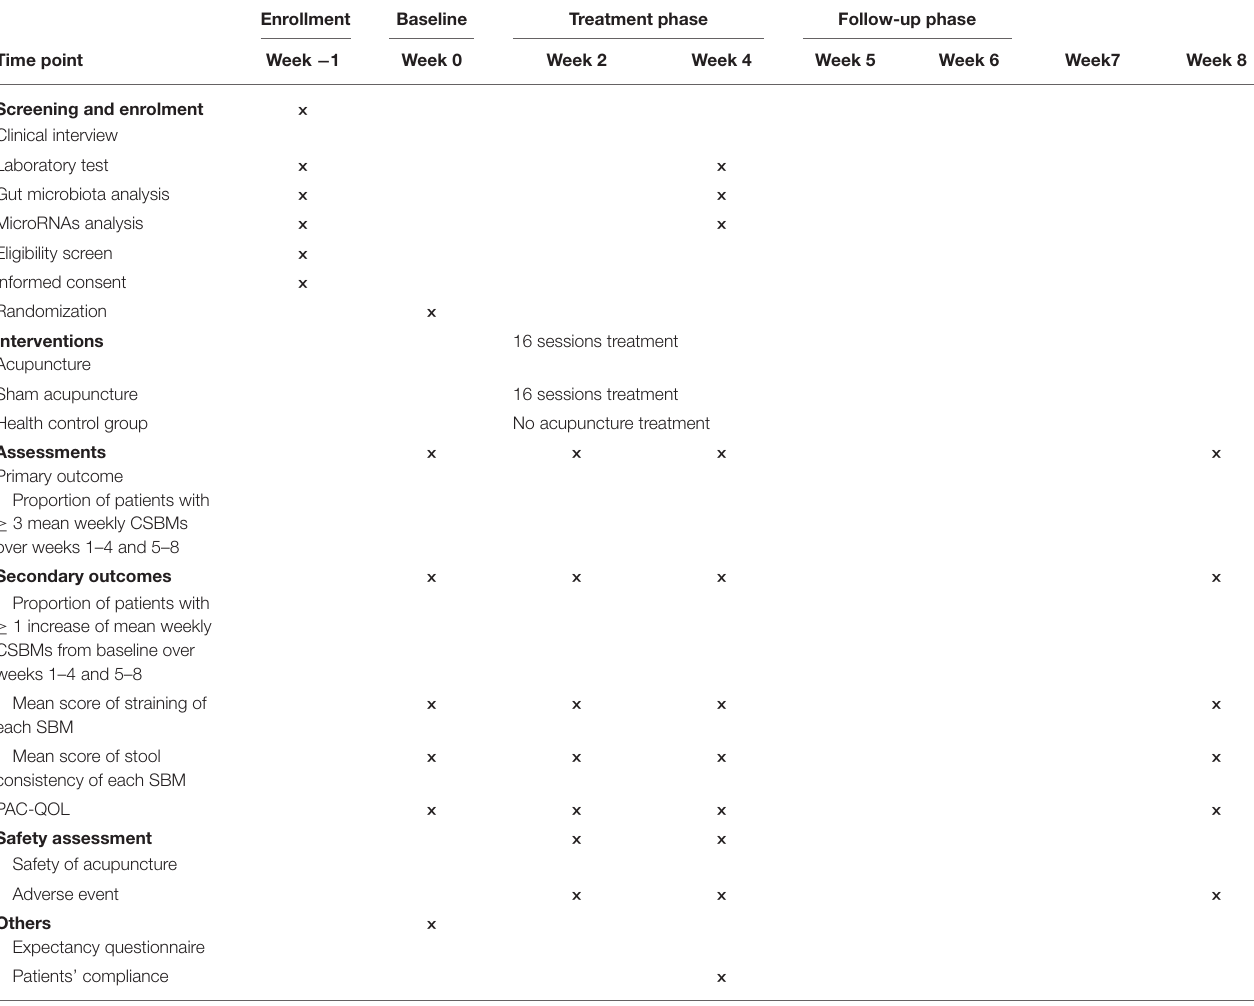
TABLE 1 | Time points of treatment